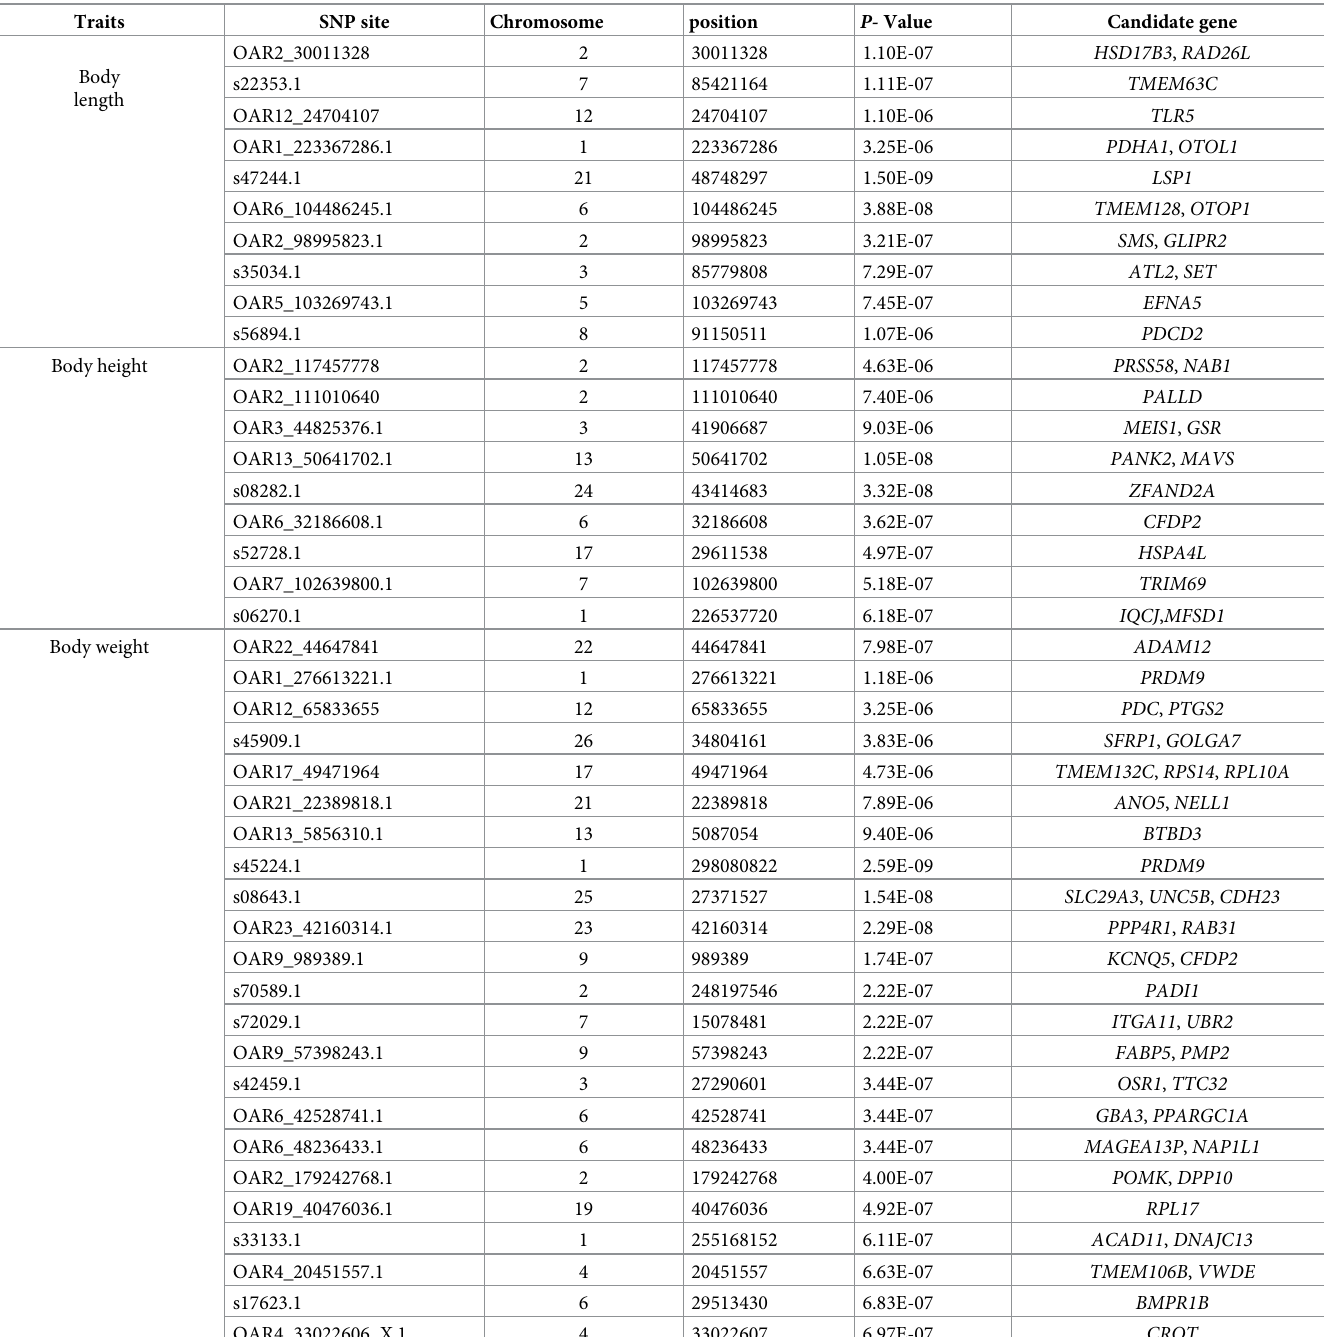
Table 3. Genome-wide association analysis results and candidate genes of growth traits of Qira Black sheep and German Merino sheep.